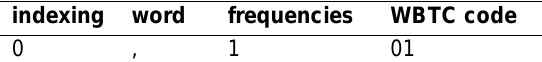
Table 12: Wt for Table 6